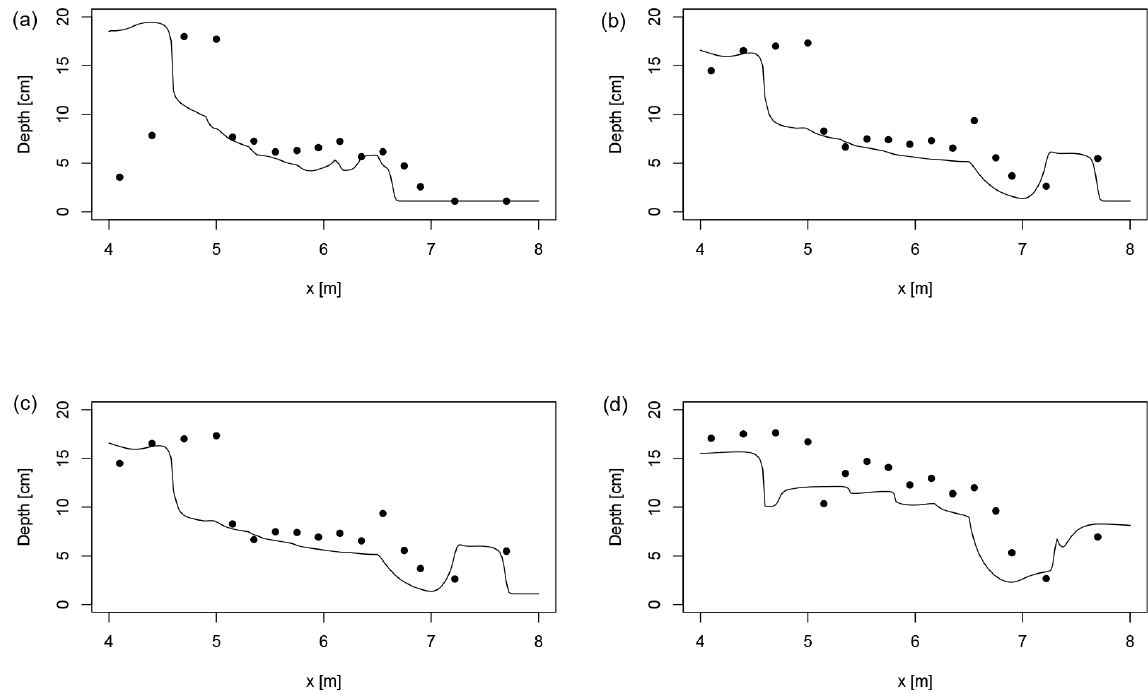
Figure A9. Simulated (lines) and experimental (points) water depth profiles at y = 0.2m, at four times (4, 5, 6 and 10s, a to d ) for the idealised urban dam break case.